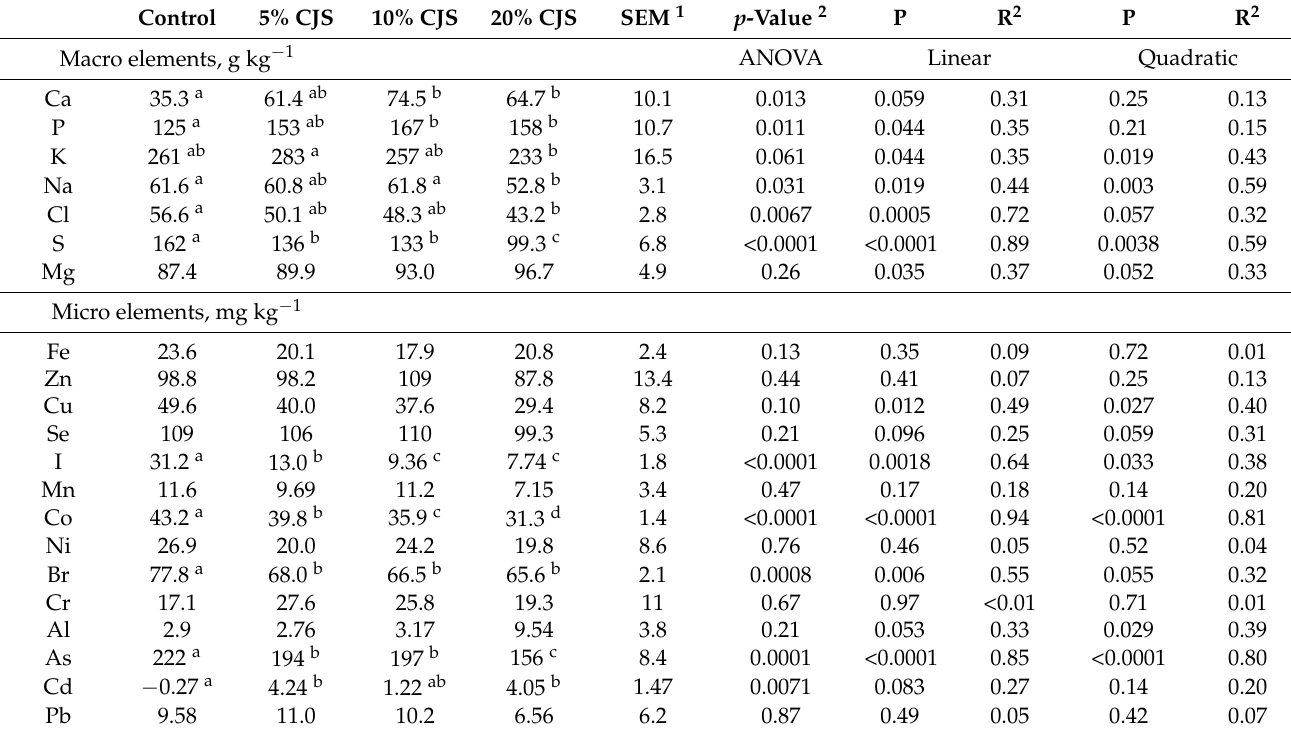
Table 10. Retention of minerals (% of ingested) in Atlantic salmon ( Salmo salar ) from the retention experiment where salmon were fed increasing levels of Cyberlindnera jadinii